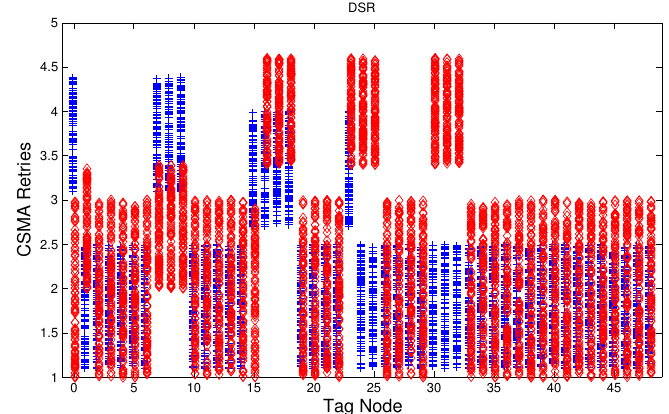
Figure 8. Average number of retries (MAC algorithm) for the nodes from Figure 3 for DSR (Dynamic Source Routing) under normal (blue) and jamming (red)